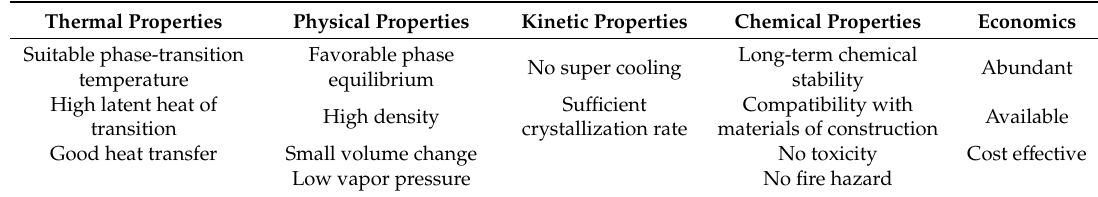
Table 2. Properties of Phase Change Materials [26,27].